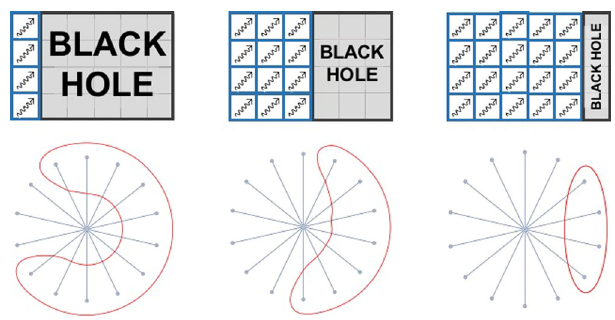
Fig. 5 Extreme rays versus black hole evaporation. In ref. 24 Page discusses black hole evaporation as a pure state in a box, divided into two parts: the black hole (whose size decreases in time) and radiation (which is complementary so its size increases in time). By Page's theorem 29 , the entropy of radiation in a random such state is the smaller of the two sizes, which gives the Page curve. A sliding division of a random multi-partite state into a black hole component (circled red) and radiation components effectively constructs fl ower graphs. In this fi gure time fl ows from left to